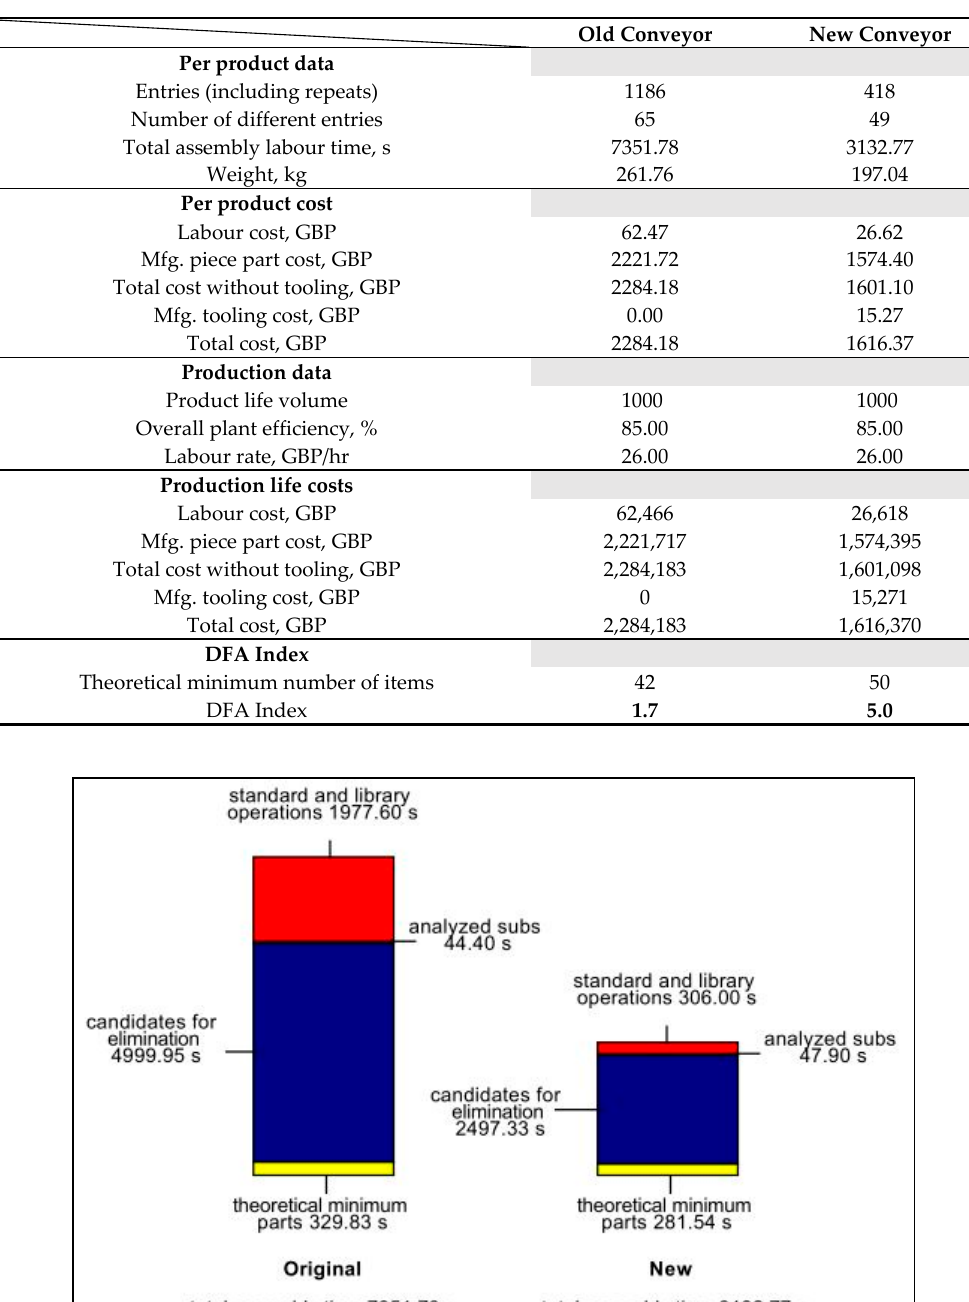
Figure 16. Time distribution chart for old and new conveyors.